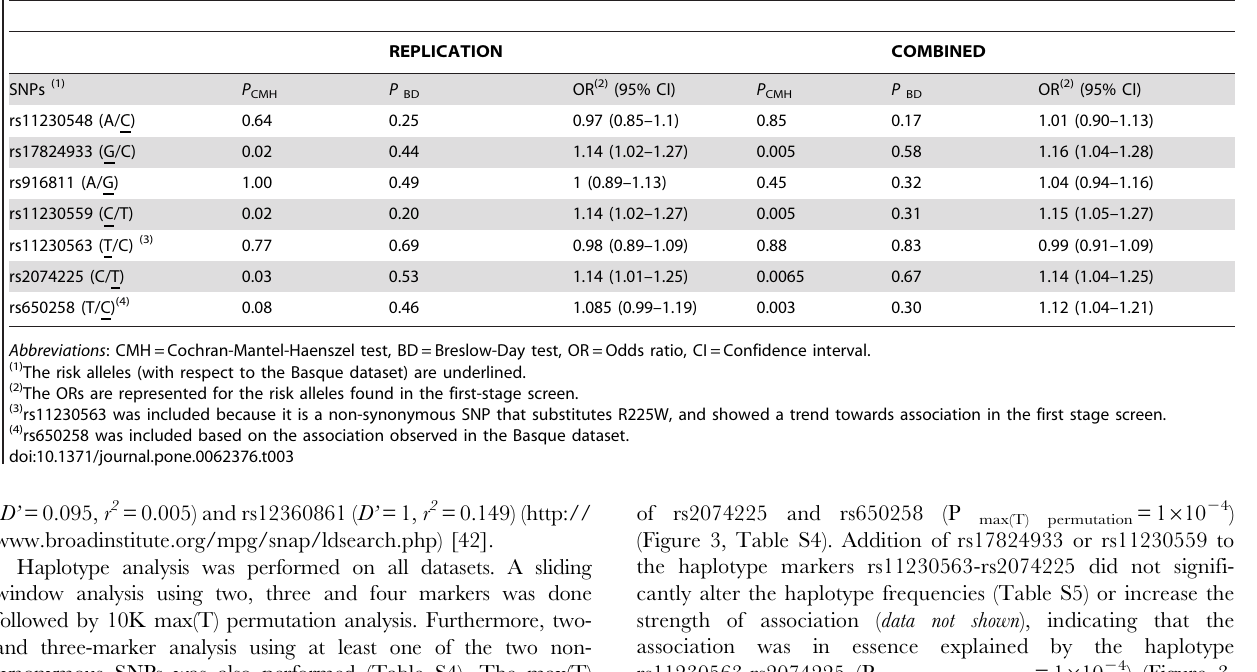
Table 3. Replication and combined analysis of the most significant SNPs.